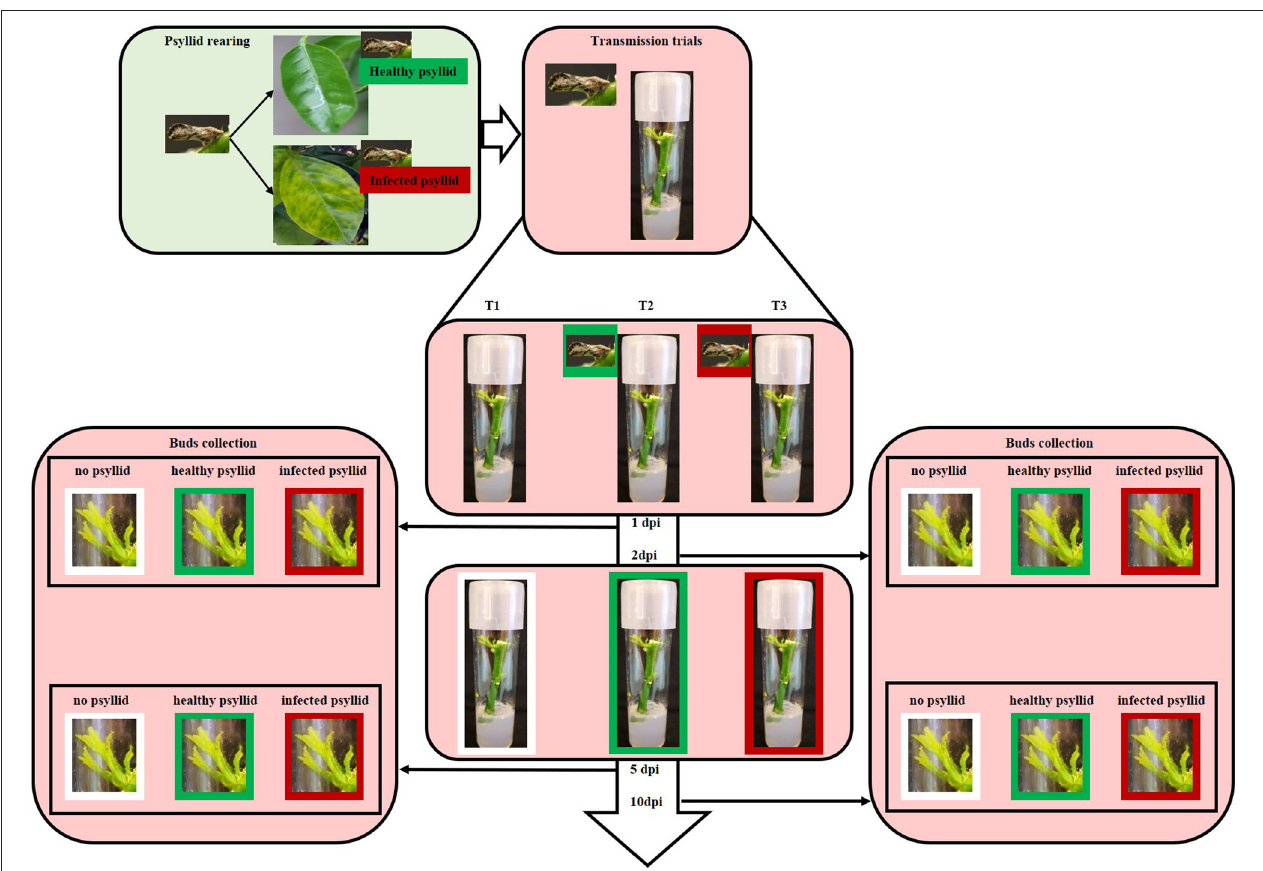
FIGURE 1 | Diagram illustrating the rearing and infection of Ca Las and the transmission trials. Colonies of healthy psyllids were reared on HLB-free curry leaf plants in a growth room. Ca Las- infected psyllids were maintained on Ca Las-infected citrus trees in a growth room at the Citrus Research and Education Center of the University of Florida. For the transmission trials, five healthy or infected adult psyllids were put into each respective tissue culture tube when leaves of budwood sprouts began to unfold. Tissue was harvested from some of the plantlets at 1, 2, 5, and 10 days post-infection